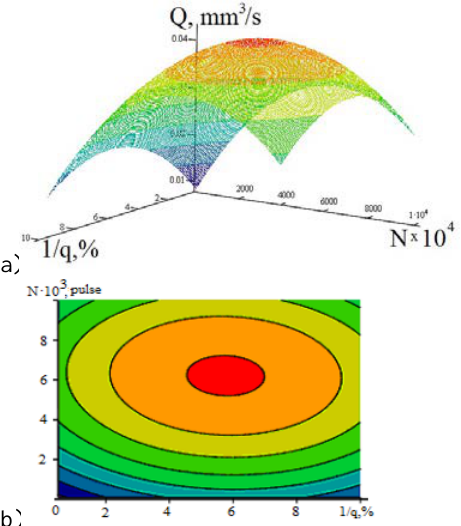
Fig.1. The dependence of the die-sinking EDM productivity on the number of discharge pulses and the part of the pulse width for the period: a-volumetric graph; b - projection in the plane